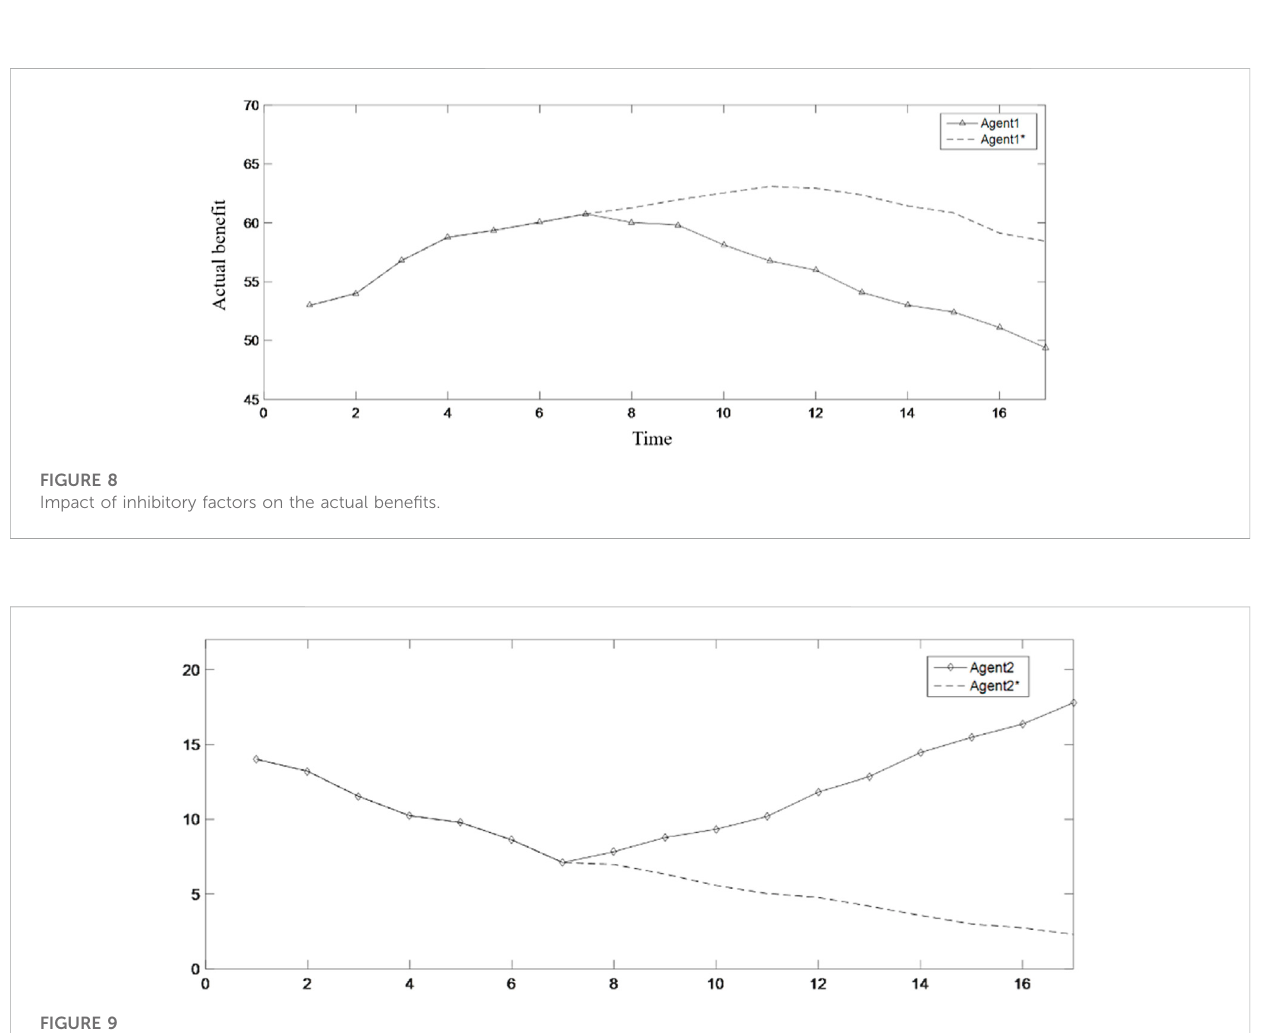
the bene fi t of Agent 1 drops to the lowest point 42.02 and the last time, the bene fi t drops to the lowest point 43.91. It shows that as the number of games increases, the stimulus for Agent 1 to reduce its bene fi t becomes smaller each time, and the manifestation is that the reduction